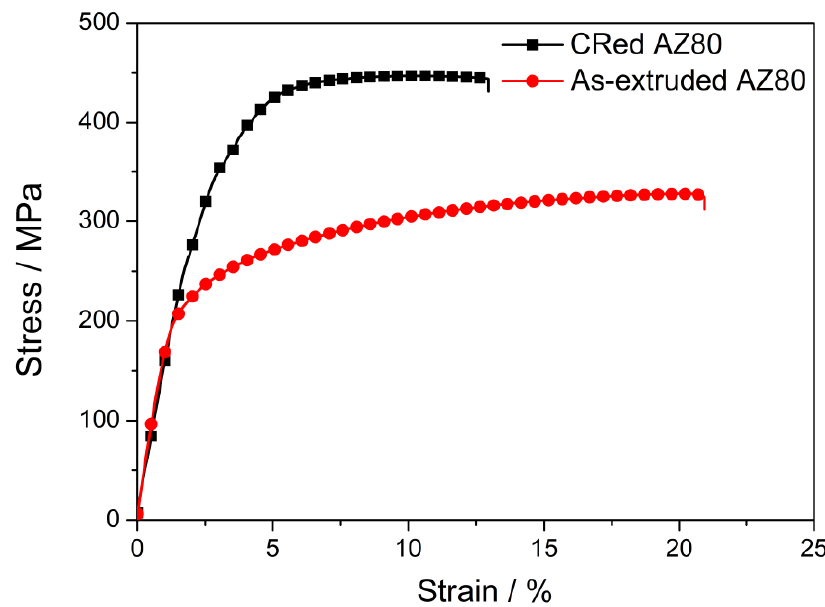
Figure 8. Typical tensile stress-strain curves of CRed AZ80 alloy compared with as-extruded AZ80 sample. Table 1. Tensile properties of CRed AZ80 compared with as-extruded sample.